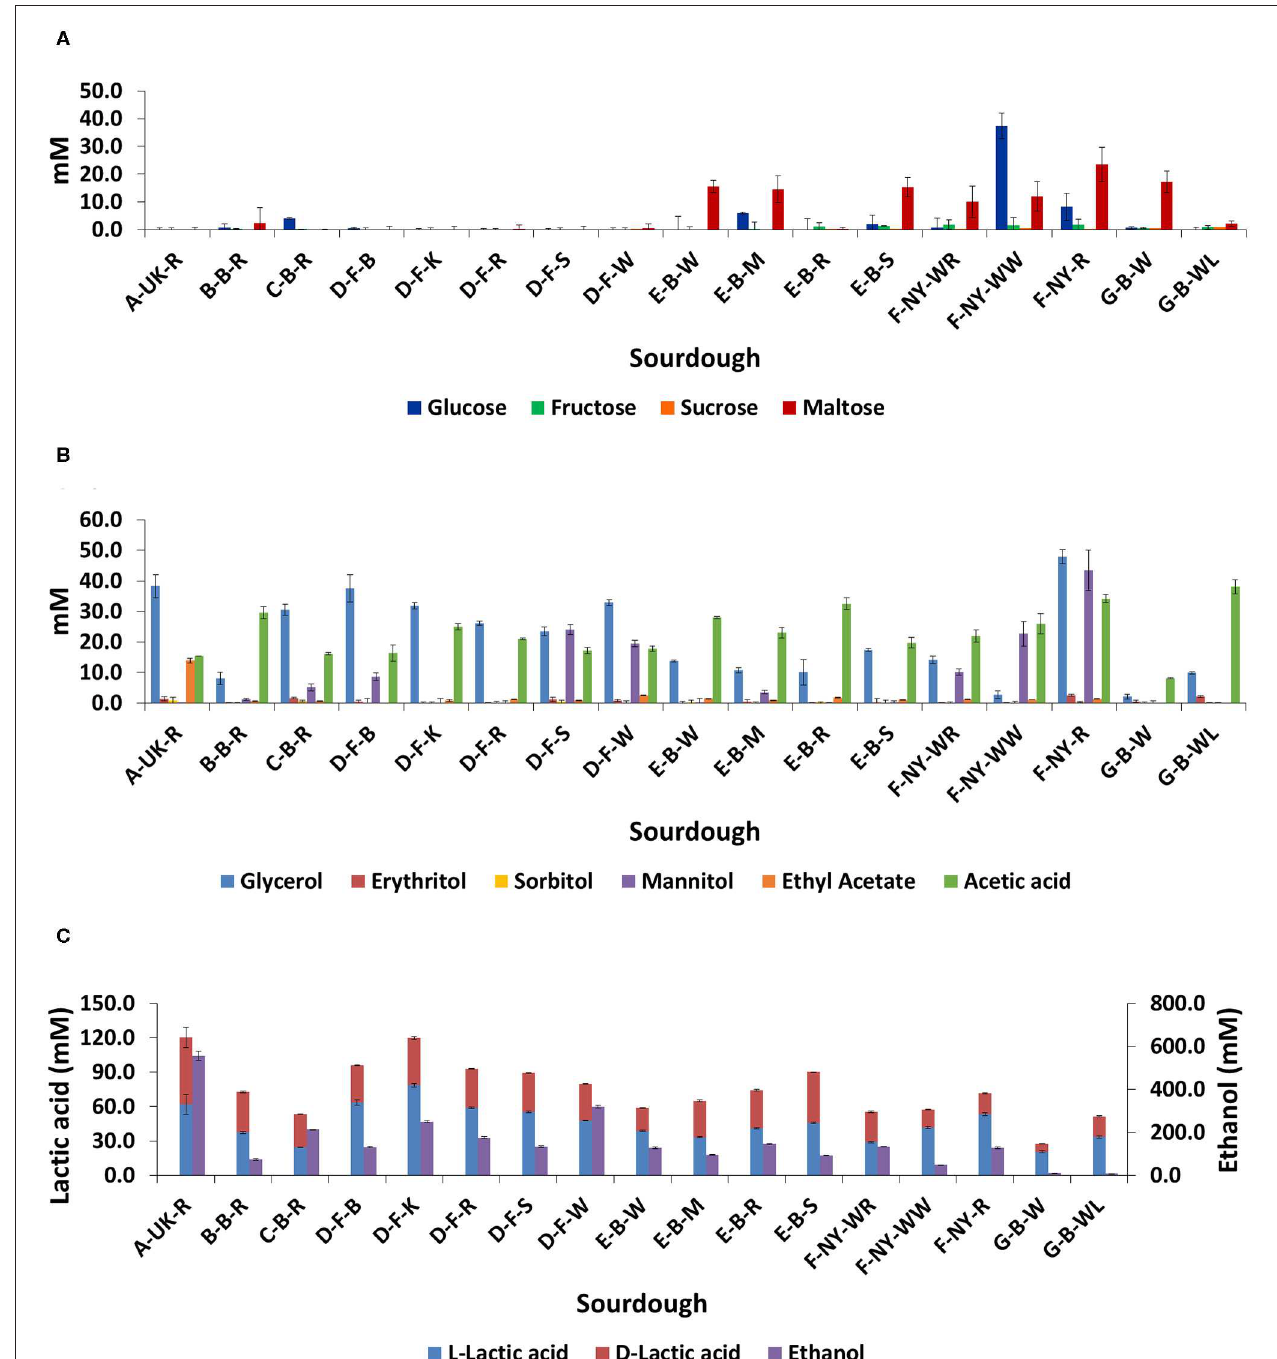
FIGURE 7 | Residual concentrations of glucose, fructose, sucrose, and maltose (A) , and the concentrations of glycerol, erythritol, sorbitol, mannitol, ethyl acetate, acetic acid (B) , L-lactic acid, D-lactic acid, and ethanol (C) in 17 sourdough samples from backslopped sourdoughs of different origins. The sample codes are as described in Table 1